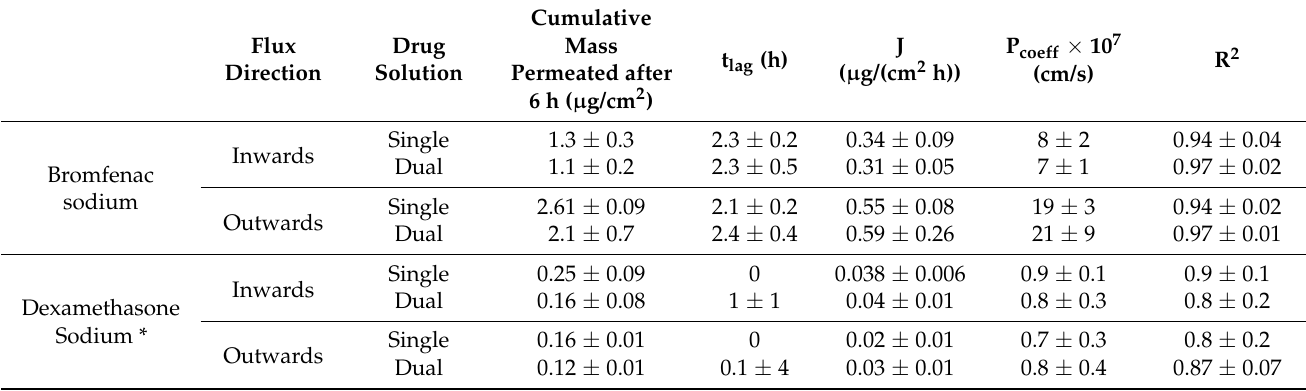
Table 1. Cumulative mass permeated after 6 h, lag-time (t lag ), steady state flux (J) and permeability coefficient (P coeff ) of the drugs when tested as a single-drug solution (Single) or dual-drug solution